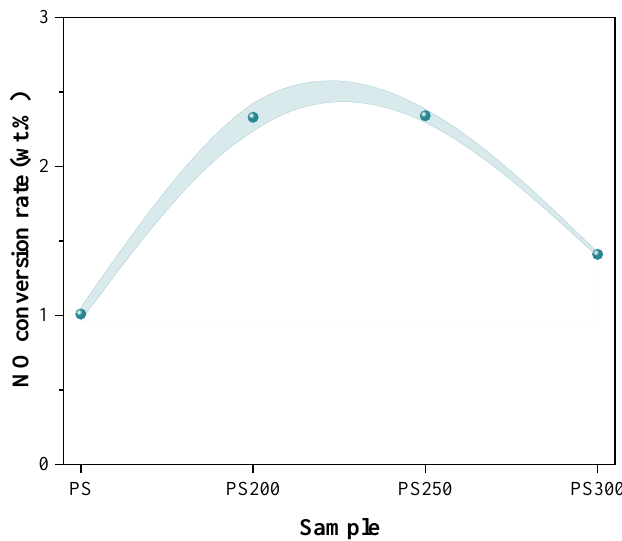
Figure 6. Conversion rate of fuel-N to NO during combustion.